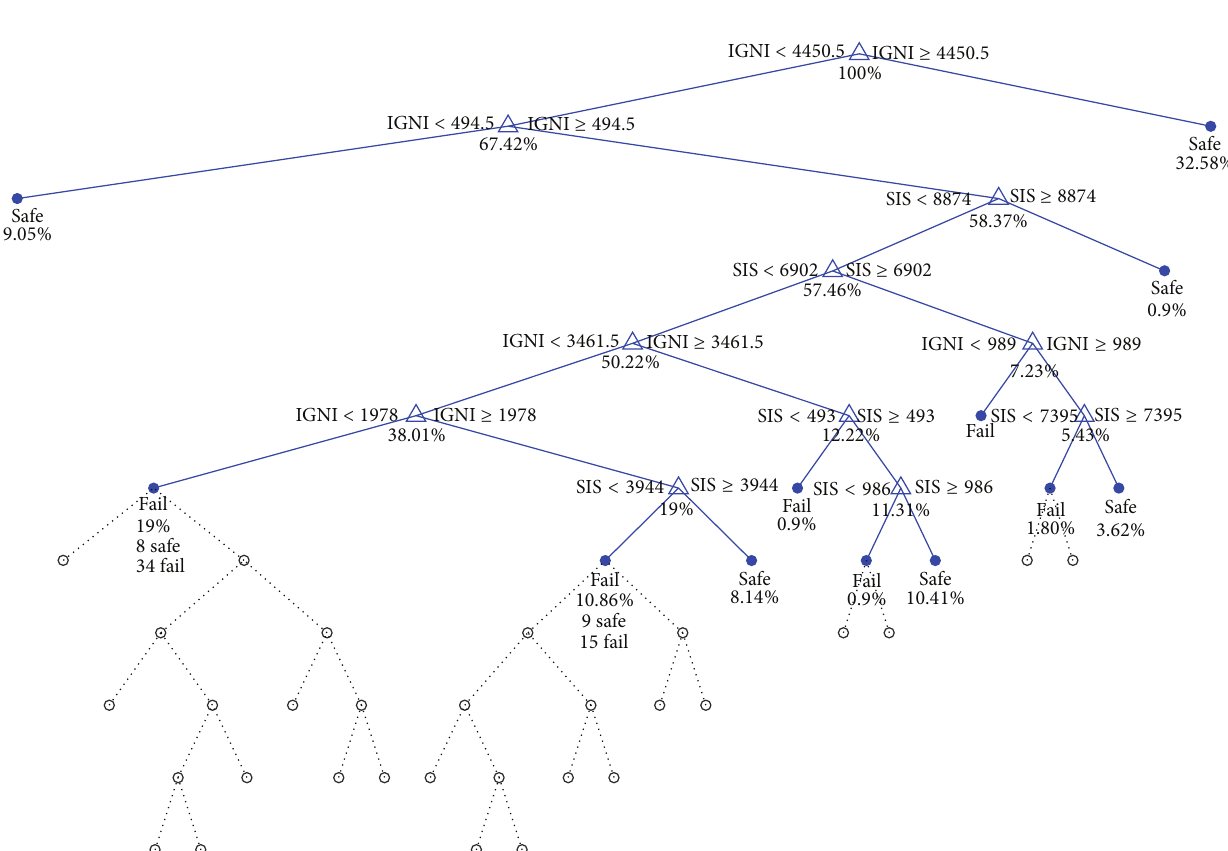
Figure 10: Decision tree fitted into clustering results data for the sequence [ INI SIS IGNI ] (sec) with